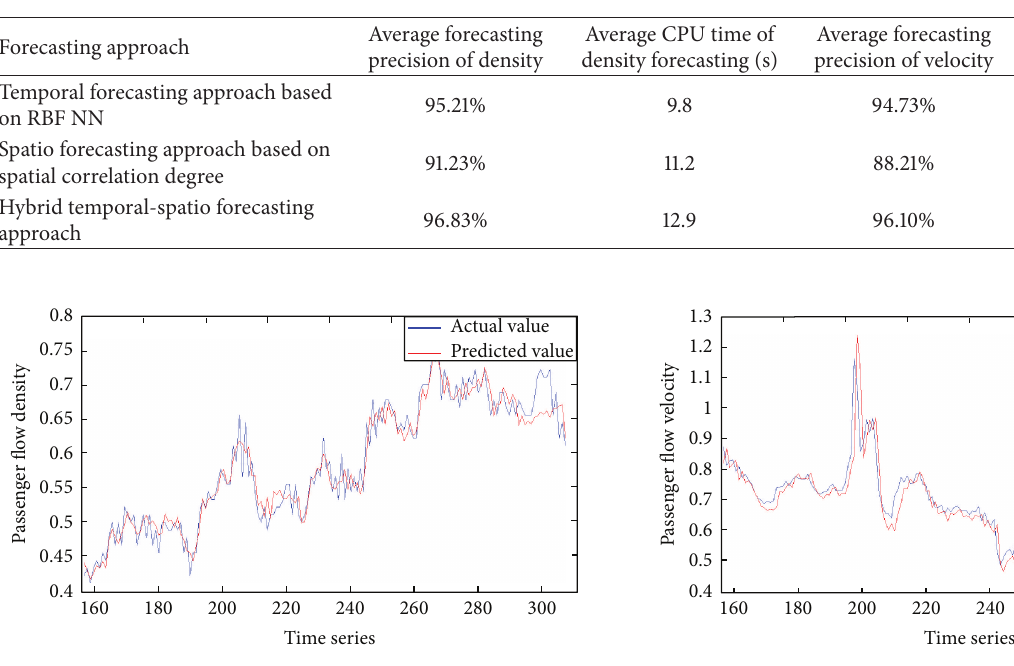
Table 3: Average forecasting precision comparison of three approaches.